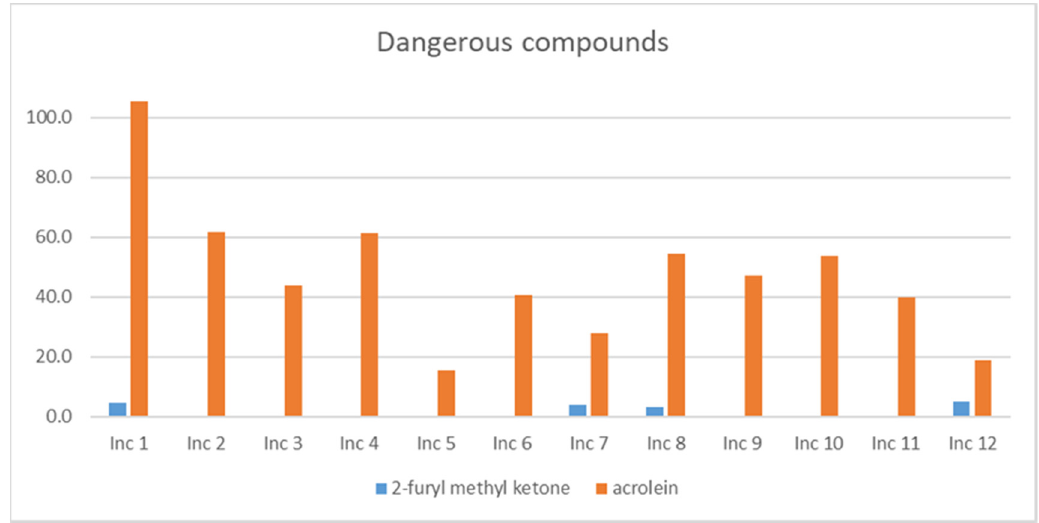
Figure 4. STPC concentrations ( μ g/m 3 ) for other dangerous (fatal) compounds in the twelve products studied.